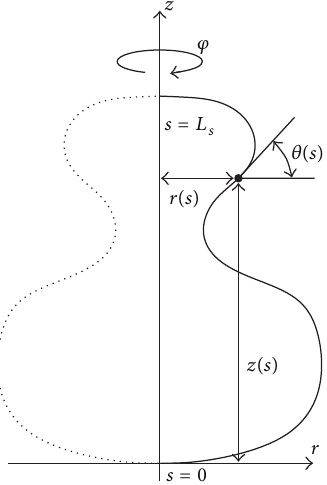
Figure 1: Vesicle profile representation on 𝑟 - 𝑧